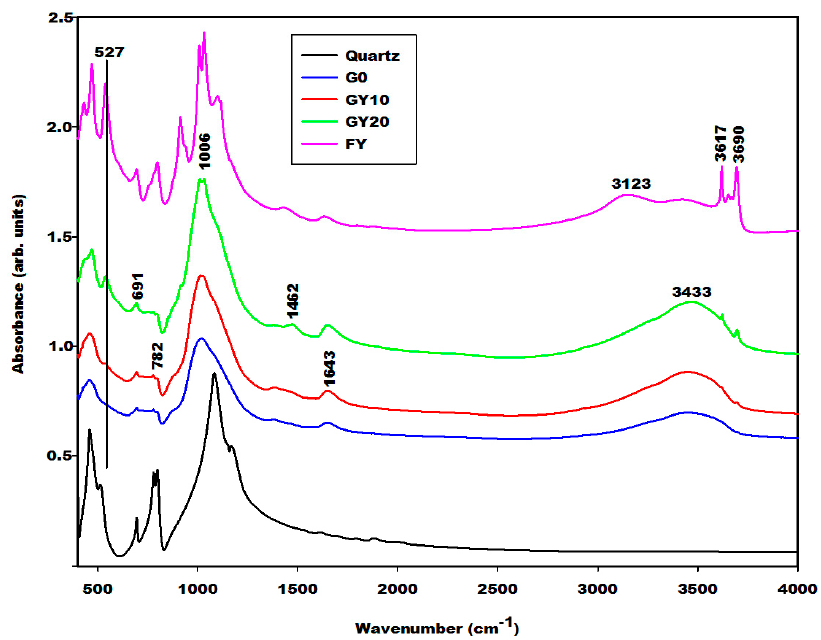
Figure 10. Infrared spectra of geopolymer materials (G0, GY10, GY20, quartz and FY: Goethite and kaolinite).